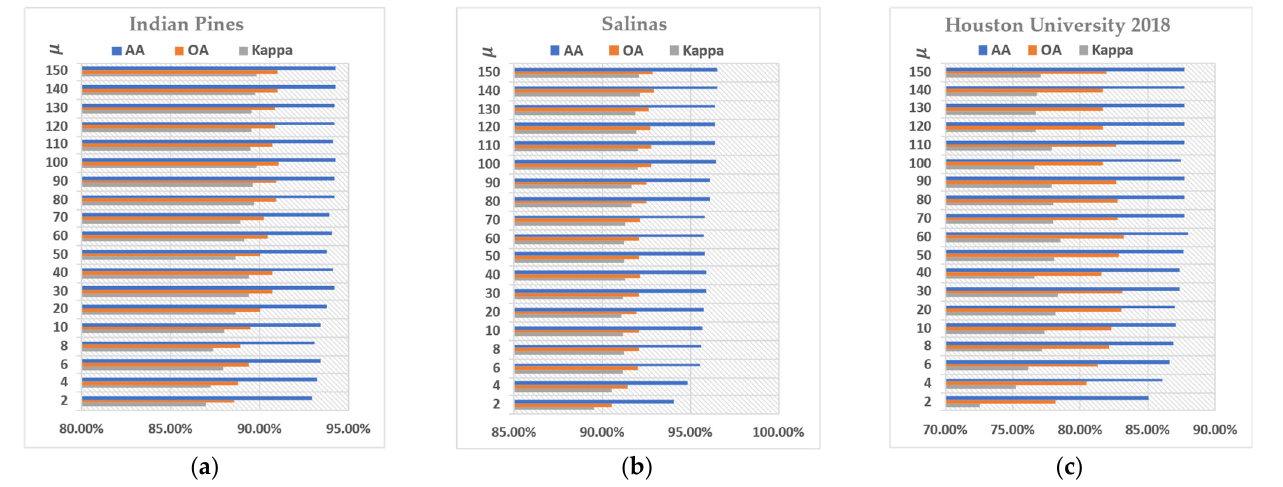
Figure 10. Analysis of the sensitivity of parameter 𝜇 in the second stage for three datasets. Classification results: (a ) Indian Pines; ( b ) Salinas; ( c ) Houston University 2018.